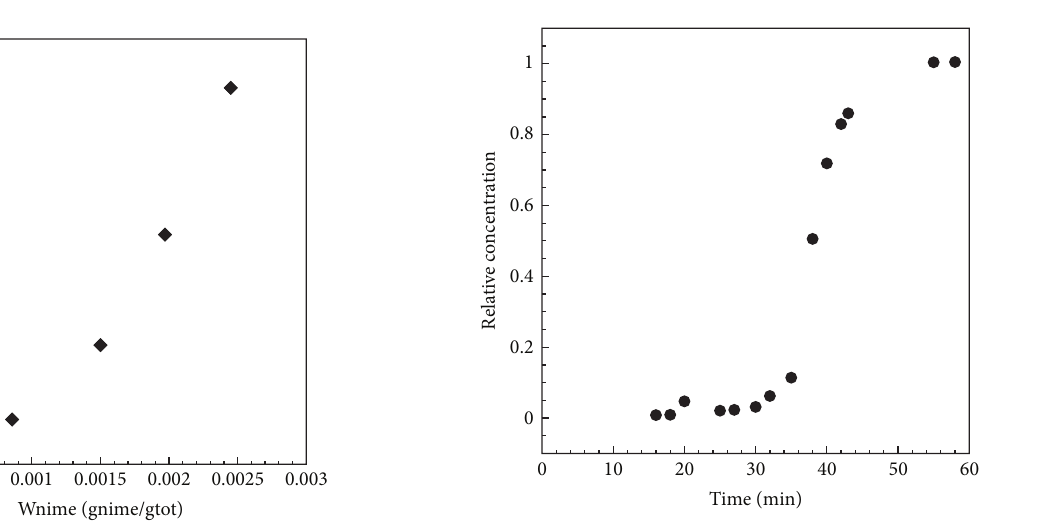
Figure 3: Breakthrough curve for adsorption of nimesulide on silica aerogel bed from a stream of CO 2 and ethanol at 40 ∘ C, flow rate = = 0.378 , 𝐶 = 0.00174 mg/mL, bed 𝐿/𝐷 = 6.89 mL/min, 𝑋 0 nime CO 2 9.7